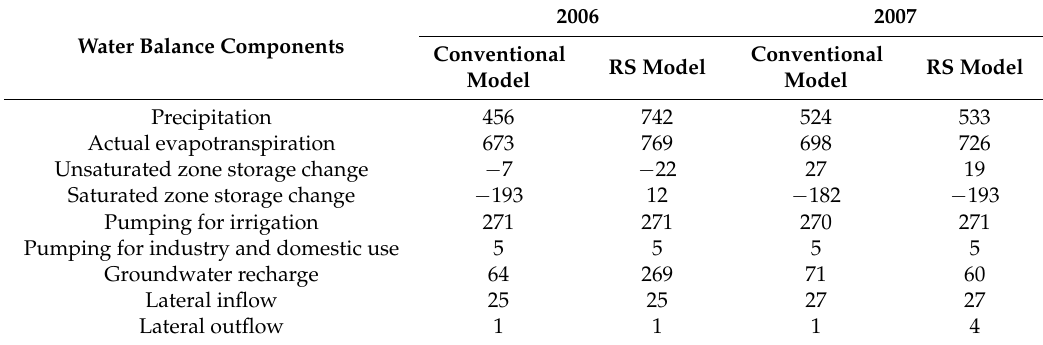
Table 5. Simulated water balance components in 2006 and 2007 (Unit: